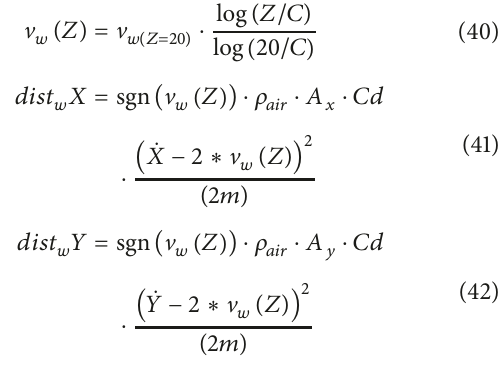
twice the Z one. Due to this assumption, there appears a